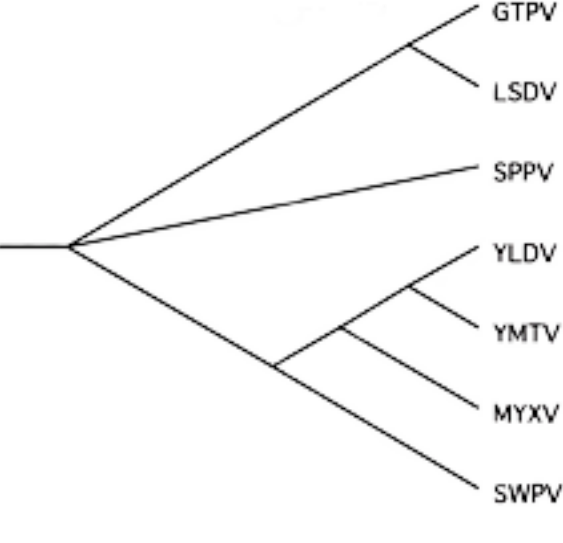
Figure 2. Cladogram made using a ClustalW whole genome alignment of the seven poxvirus genomes.